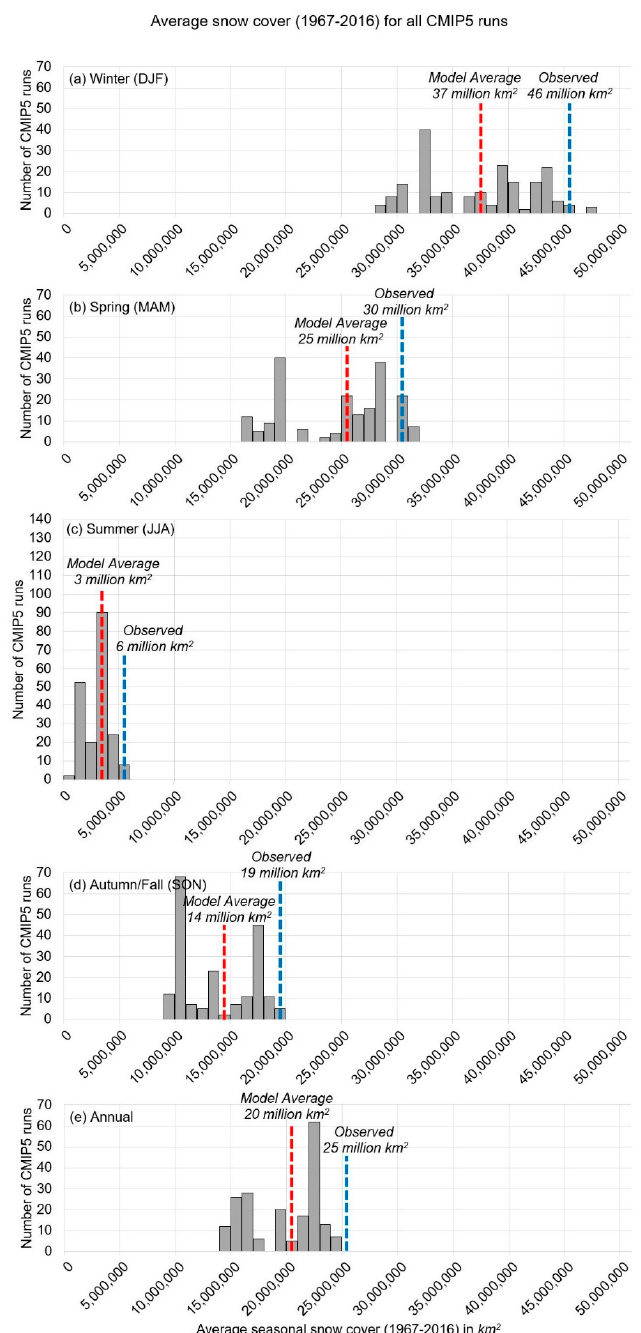
Figure 2. Estimated 1967–2016 Northern Hemisphere snow cover area for each of the 196 CMIP5 simulations for ( a ) winter, ( b ) spring, ( c ) summer, ( d ) autumn/fall, and ( e ) annual averages. The observed areas for each season (or yearly average) are indicated with dashed, blue lines in each